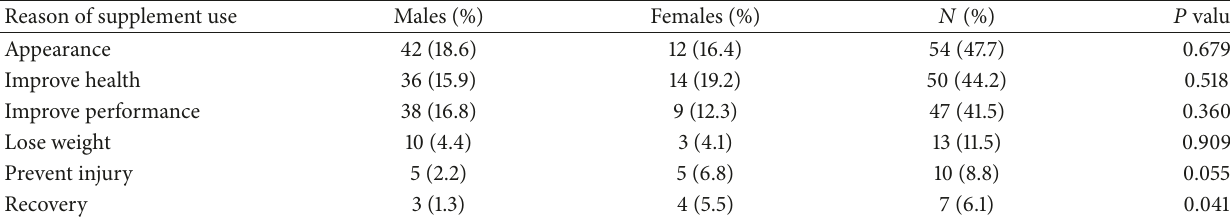
Table 5: Reasons for supplement